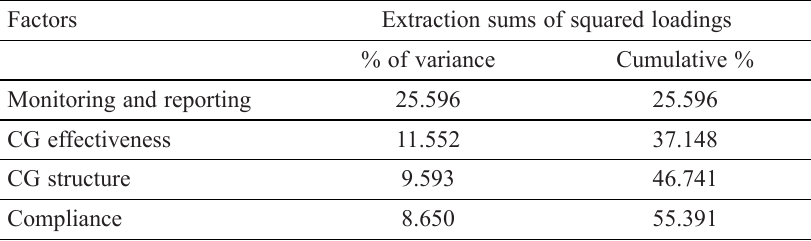
Table 5. Percent of explained variance by factors underlying extension